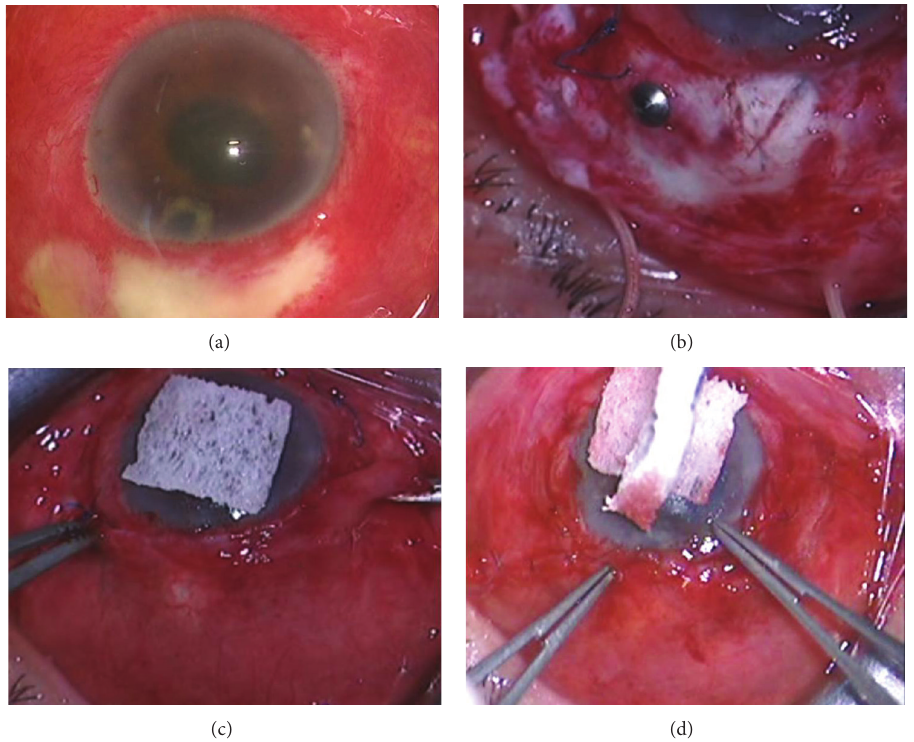
Figure 2: Surgical procedure of the infected bleb excision and conjunctival advancement. All figures are surgeon’s view. (a) The period from starting symptom to initiation of treatment is 1 day. The white bleb opacity, the conjunctival hyperemia, and the cloudy anterior chamber with inflammation can be seen. (b) The infected bleb is removed completely after pars plana vitrectomy. (c) Conjunctival advancement is performed after sufficient posterior peritomy. The scleral flap was covered with the moved residual conjunctiva from the fornix to the limbus. (d) The moved conjunctiva was sutured at the limbus by a 10-0 nylon suture with a rounded-body needle.